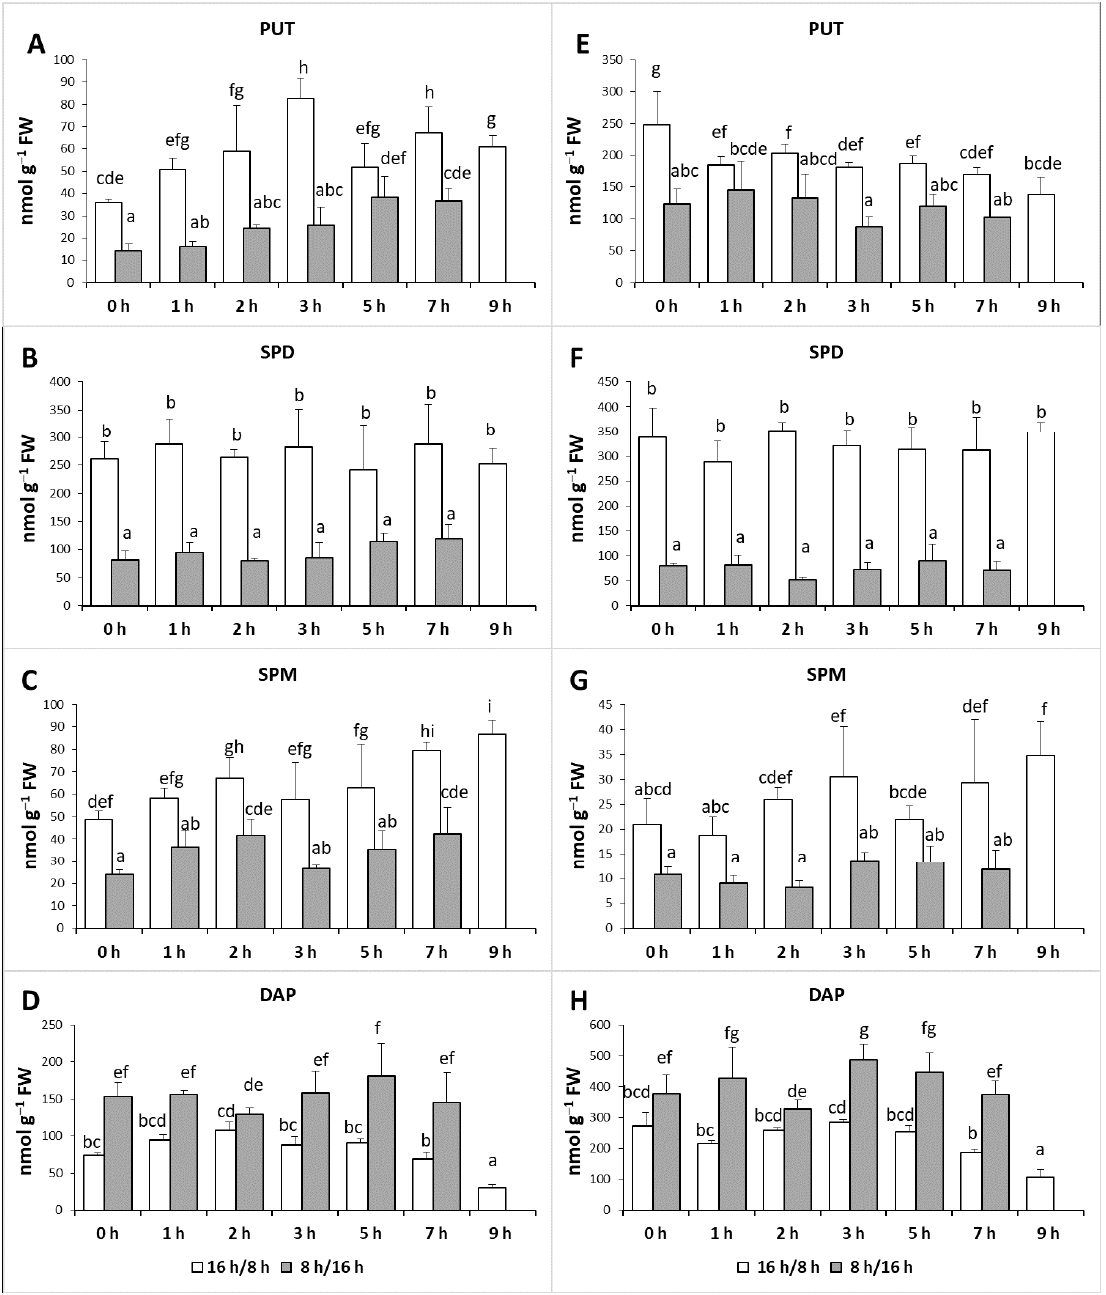
Figure 1. Effect of lighting hours on the polyamine patterns in the leaves ( A – D ) and roots ( E – H ) of plants grown under 16 h/8 h (white column) or 8 h/16 h day/night light period (dark grey column). PUT: putrescine, SPD: spermidine, SPM: spermine, DAP: 1,3-diaminopropane. Data represent mean values ± SD. Different letters indicate significant differ- ences at p ≤ 0.05 level, among all the values of the given